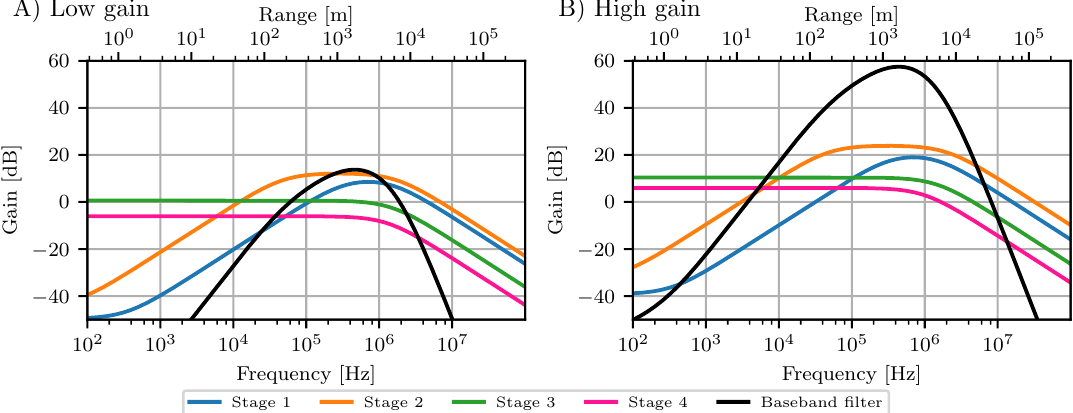
Figure 3. Amplitude response of the 4-stage active baseband filter in mGEODAR at low gain ( left A ) and high gain ( right B ) setting in black. Stage 1 and 2 define the bandpass shape and stage 3 and 4 cause a strong roll-off to high frequencies. The zero crossing in high gain setting is at 20m and the maximum pass band ranges roughly from 800m to